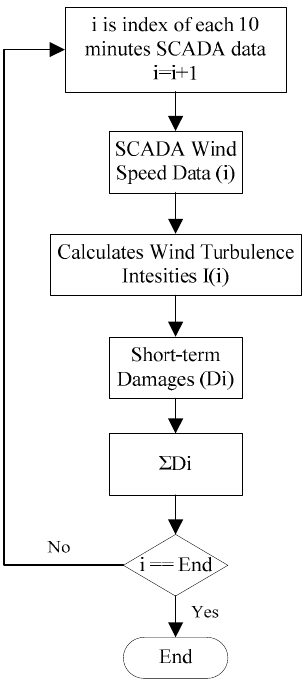
Figure 15. Procedure of long-term fatigue damage quantification by SCADA data.